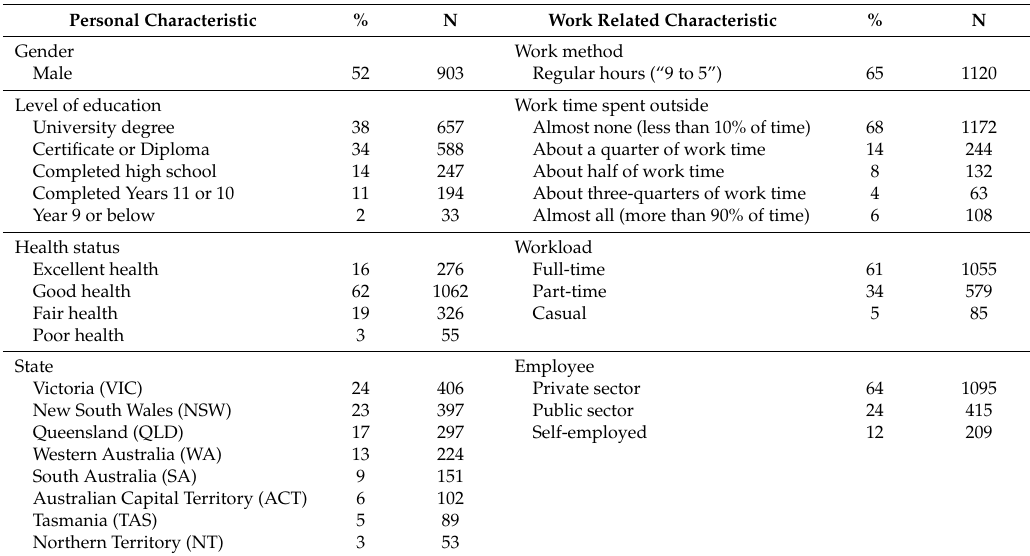
Table 1. Sample characteristics (N =